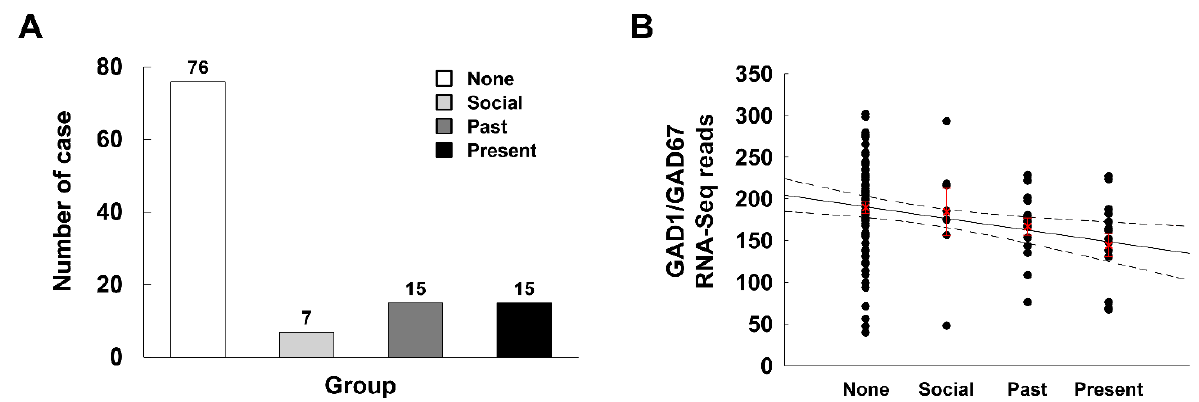
Figure 6. Correlation between GAD1/GAD67 gene expression in the human brain and the drug use severity ratings. ( A ) The number of cases in each drug use severity ratings. ( B ) The mean RNA-sequencing read counts of GAD1/GAD67 gene in each severity ratings. Data are expressed as raw data ( • ) and mean ± S.E. (X, red), and were analyzed using Pearson correlation test. The normal line is the plot of regression analysis and the dotted lines represent the 95% confidence intervals for the regression line.